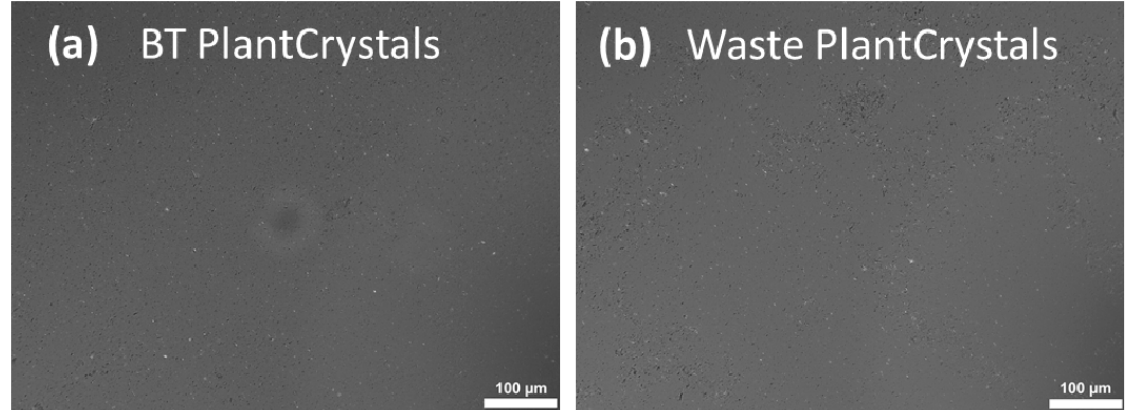
Figure 7. Light microscopic images of the obtained PlantCrystals: black tea (BT) leaves (a) and their waste (b) (200-fold magnification).